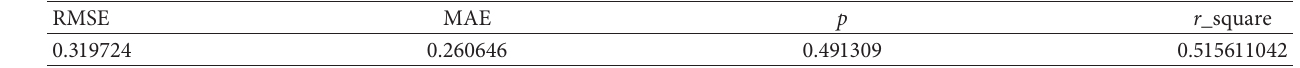
Table 25: Prediction error of quantile based neural network and model integration algorithm.